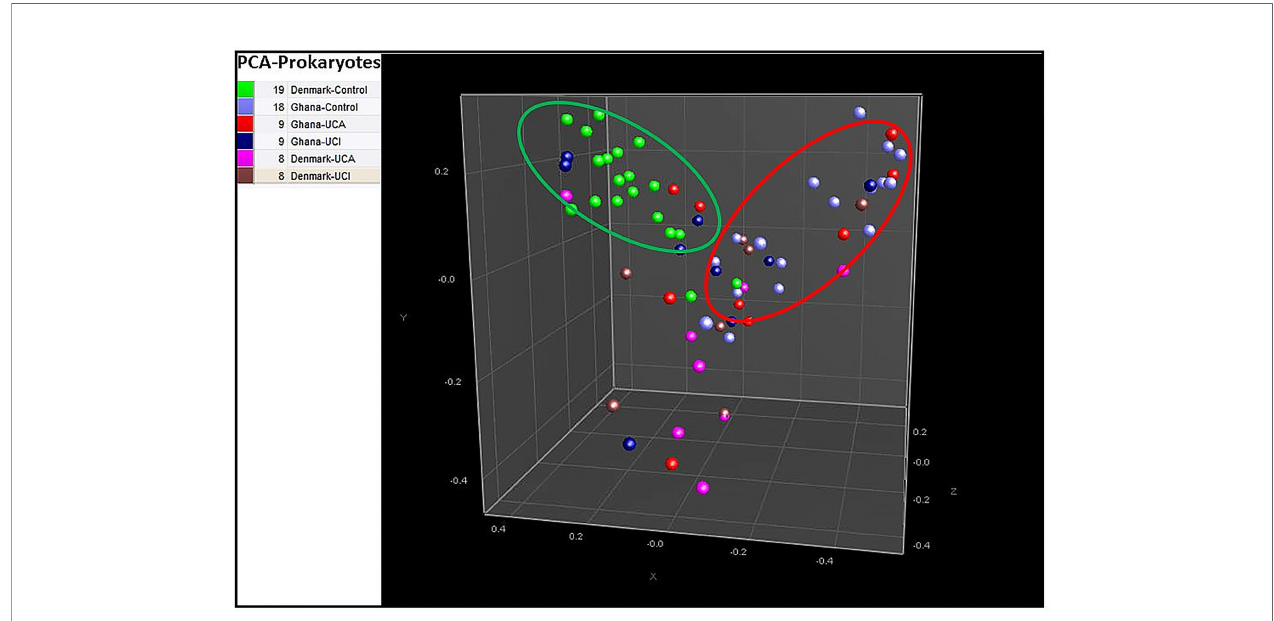
FIGURE 2 | Principal component analysis (PCA) based on prokaryotic taxonomy results show 94% of healthy controls from Denmark are in the middle of the PCA in green circle, while 88% of the healthy controls from Ghana are clustered together with UC patients from Denmark and Ghana in the red circle.